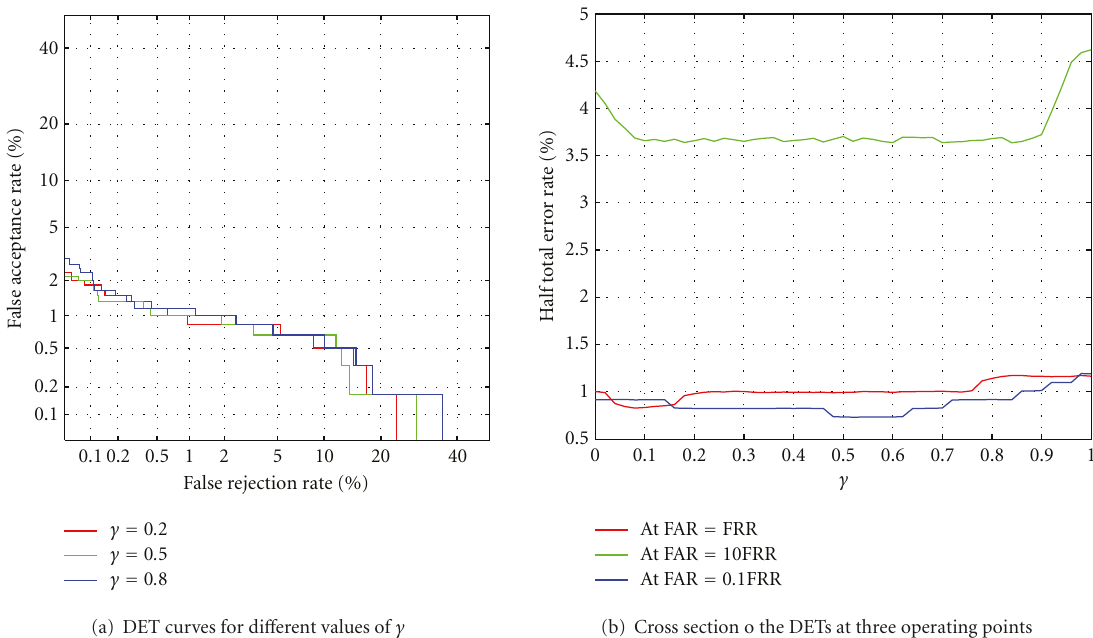
Figure 18: Assessment of the CFGC technique on the XM2VTS database.